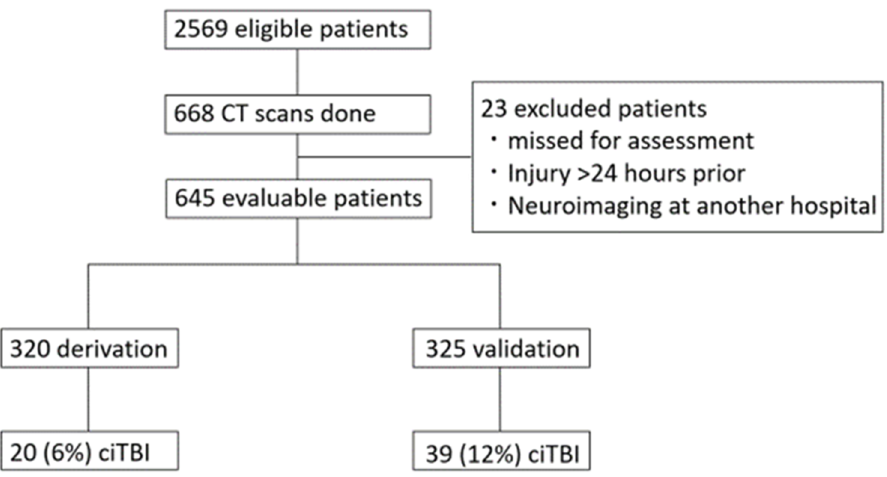
Figure 1. Flow diagram of patient selection. ciTBI, clinically important traumatic brain injury; CT, computed tomography.